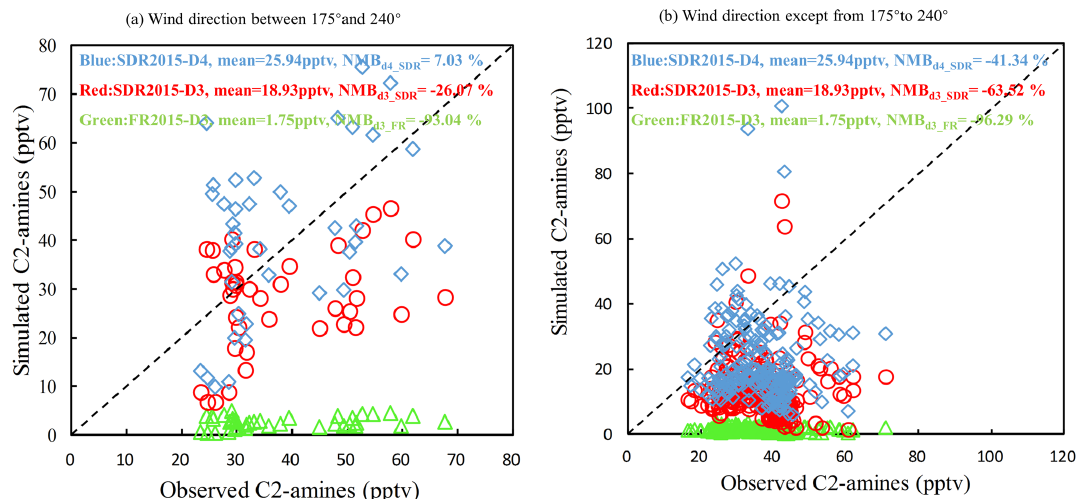
Figure 10. Comparisons of simulated and observed C2-amines at the Fudan site for different wind direction zones: (a) wind directions between 175 and 240 ◦ when the Fudan site is downwind of high residential emissions; (b) other wind directions. NMB d3_SDR , NMB d4_SDR , and NMB d3_FR represent normalized mean bias in domain 3 and domain 4 based on SDR and domain 3 based on FR, respectively.